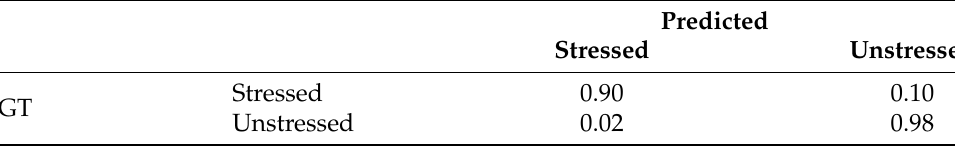
Table 3. Normalised confusion matrix for cumulative